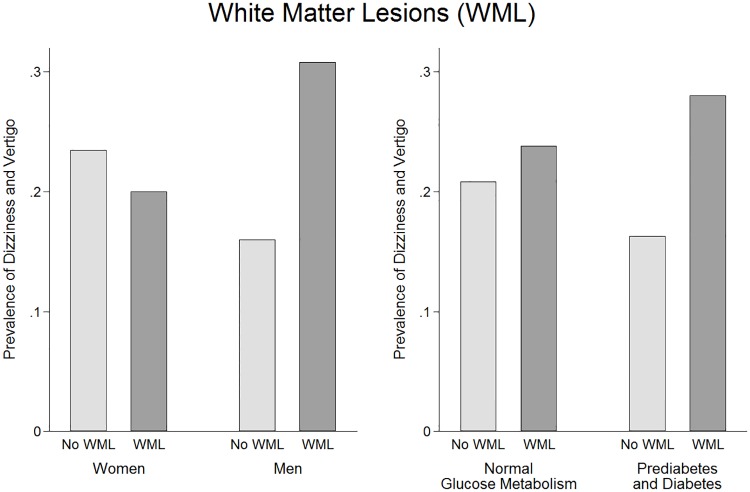
Prevalence of 12-month dizziness and vertigo according to groups with and without white matter lesions.In women and men (Panel A) and in persons with normal glucose metabolism and in prediabetic or diabetic persons (Panel B).